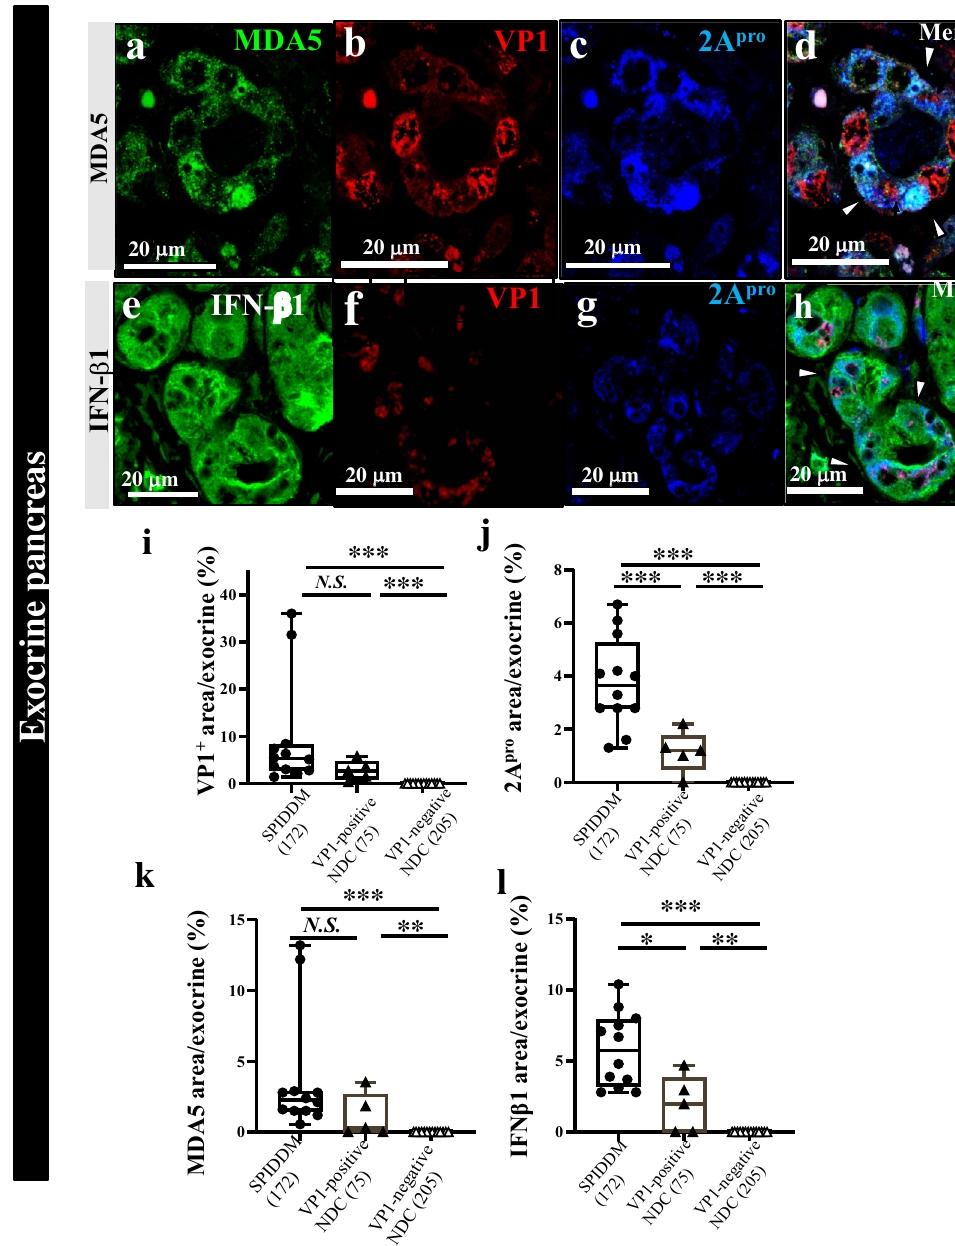
Figure 5. Innate immune responses to EV infection in the exocrine pancreas of SPIDDM and non-diabetic controls. (a–d) Triple immunostaining for MDA5 ( a ) VP1 ( b ), and 2A pro ( c ) shows exocrine acinar cells changed to ADM in SPIDDM (Case SP7). Merged image ( d ) shows that VP1-positive ( b , red) and 2A pro -positive cells ( c , blue) show weak staining for MDA5 ( a , green), in accordance with the concept that 2A pro suppressed MDA5 expression in the same acinar cells. Scale bar, 20 μm. ( e–h ) Triple immunostaining for IFN-β1 ( e ), VP1 ( f ), and 2A pro ( g ) of exocrine acinar cells changed to ADM. Merged image ( h ) of ( e–g ) shows that VP1 (red) is located in the perinuclear area and INF-β1 (blue, arrowheads) cytoplasm in EV-infected acinar cells. Scale bar, 20 μm. ( i,j ) VP1- and 2A pro -positive area in the exocrine pancreas of SPIDDM and VP1-positive non-diabetic control (NDC) are higher than those of VP1-negative NDC. Numbers in the parenthesis indicate counted exocrine area. One-way analysis of variance with Tukey analysis was used. ( k,l ) MDA5- and IFN-β1-positive area in the exocrine pancreas of SPIDDM and VP1-positive non-diabetic control (NDC) are higher than those of VP1- negative NDC. Numbers in the parenthesis indicate counted exocrine area. One-way analysis of variance with Tukey analysis was